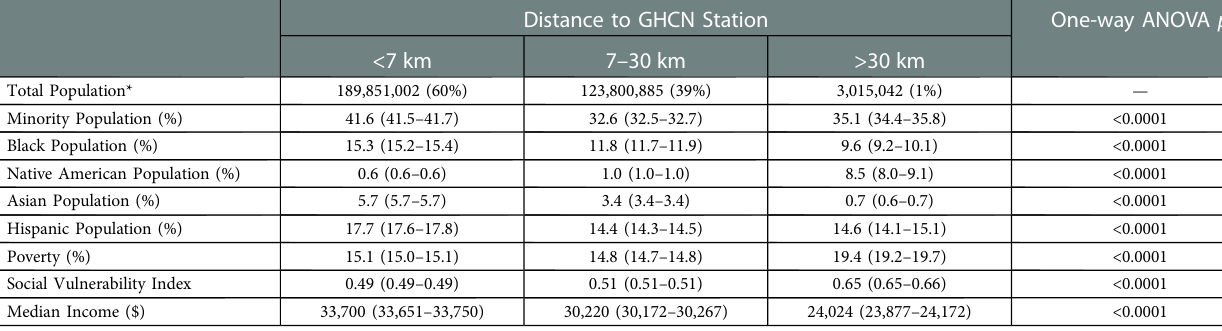
TABLE 4 Census tract population characteristics over GHCN distance Strata.